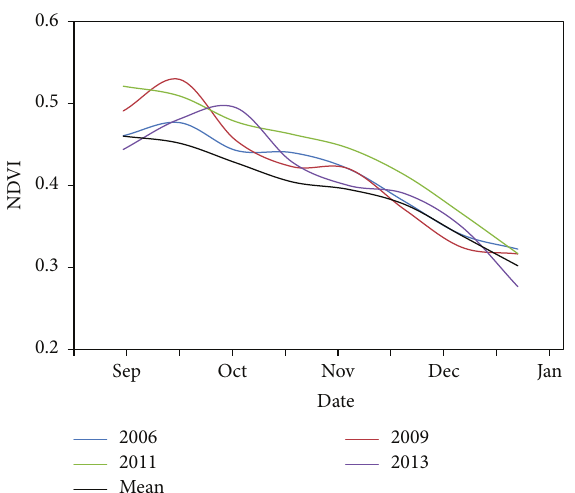
Figure 9: Variation in the NDVI from September to December during the drought years of 2006, 2009, 2011, and 2013.